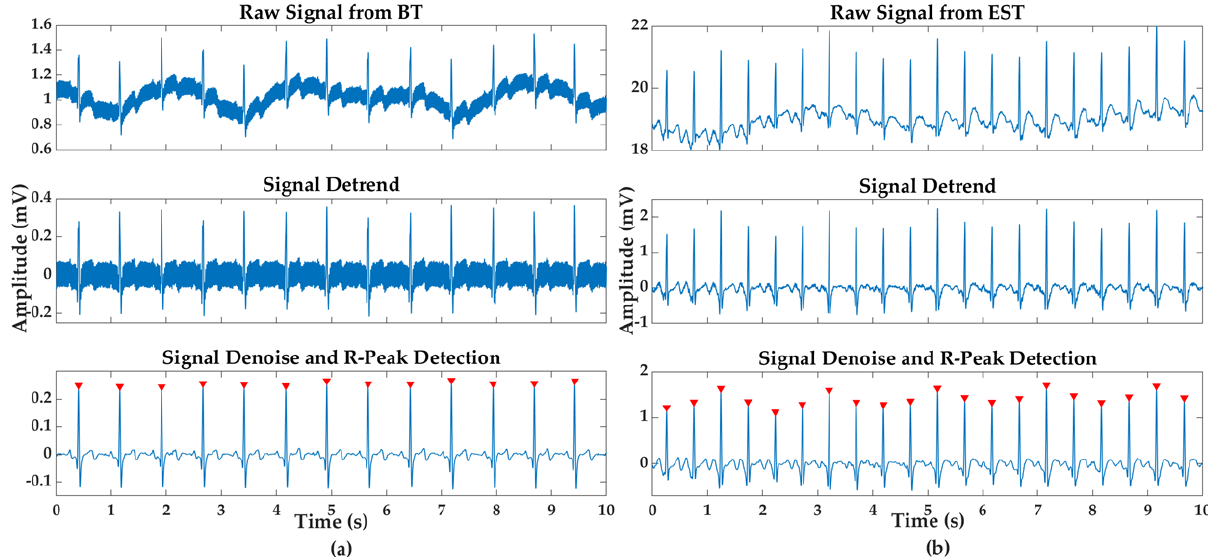
Figure 4. An example of ECG signal preprocessing and R-peak detection in 10 s. ( a ) BT ECG signal, ( b ) EST ECG signal.